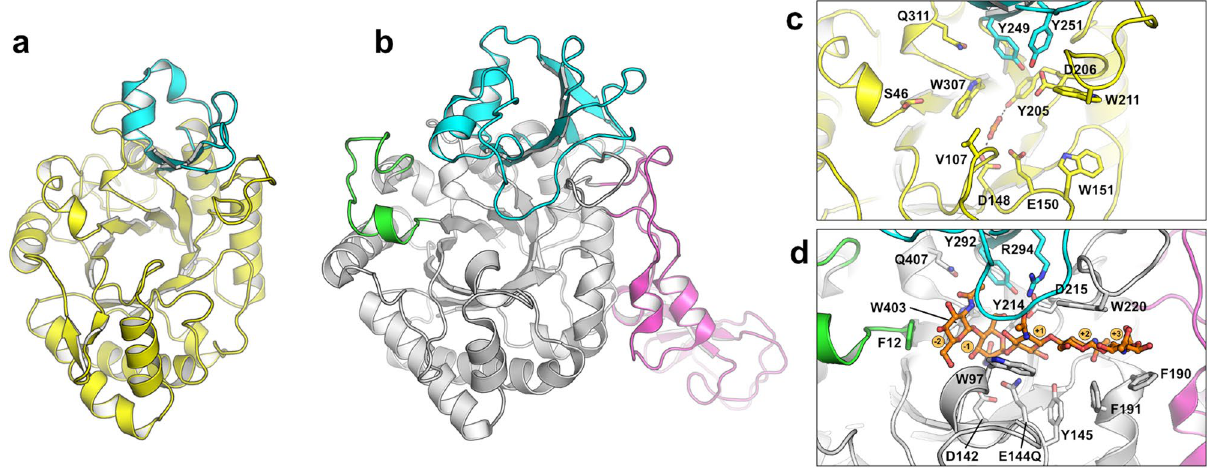
Figure 2. Structure of Fj ChiB. The overall structure of Fj ChiB (a) is shown next to Sm ChiB ( b ; PDB accession 1e6n). The chitinase insertion domain (CID) of each protein is colored cyan, and the -3-site capping loop and CBM family 5 domain of Sm ChiB are colored green and magenta, respectively. The active site architectures of Fj ChiB (c) and Sm ChiB (d) show the key residues lining the substrate binding clefts. The structure of Sm ChiB contained the catalytic residue substitution E144Q enabling the determination in complex with chitopentaose (orange sticks). Notably, the smaller CID and the lack of motifs equivalent to the capping loop of Sm ChiB lead to a more exposed substrate binding cleft in Fj